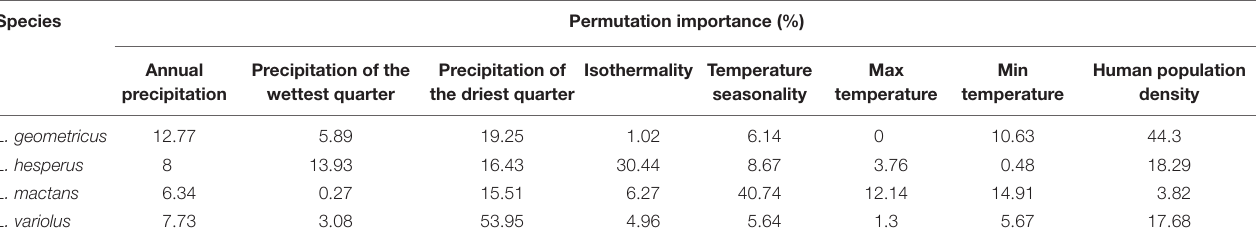
TABLE 3 | Percent permutation importance of climatic and anthropogenic predictors used in the anthropogenic model for each species.